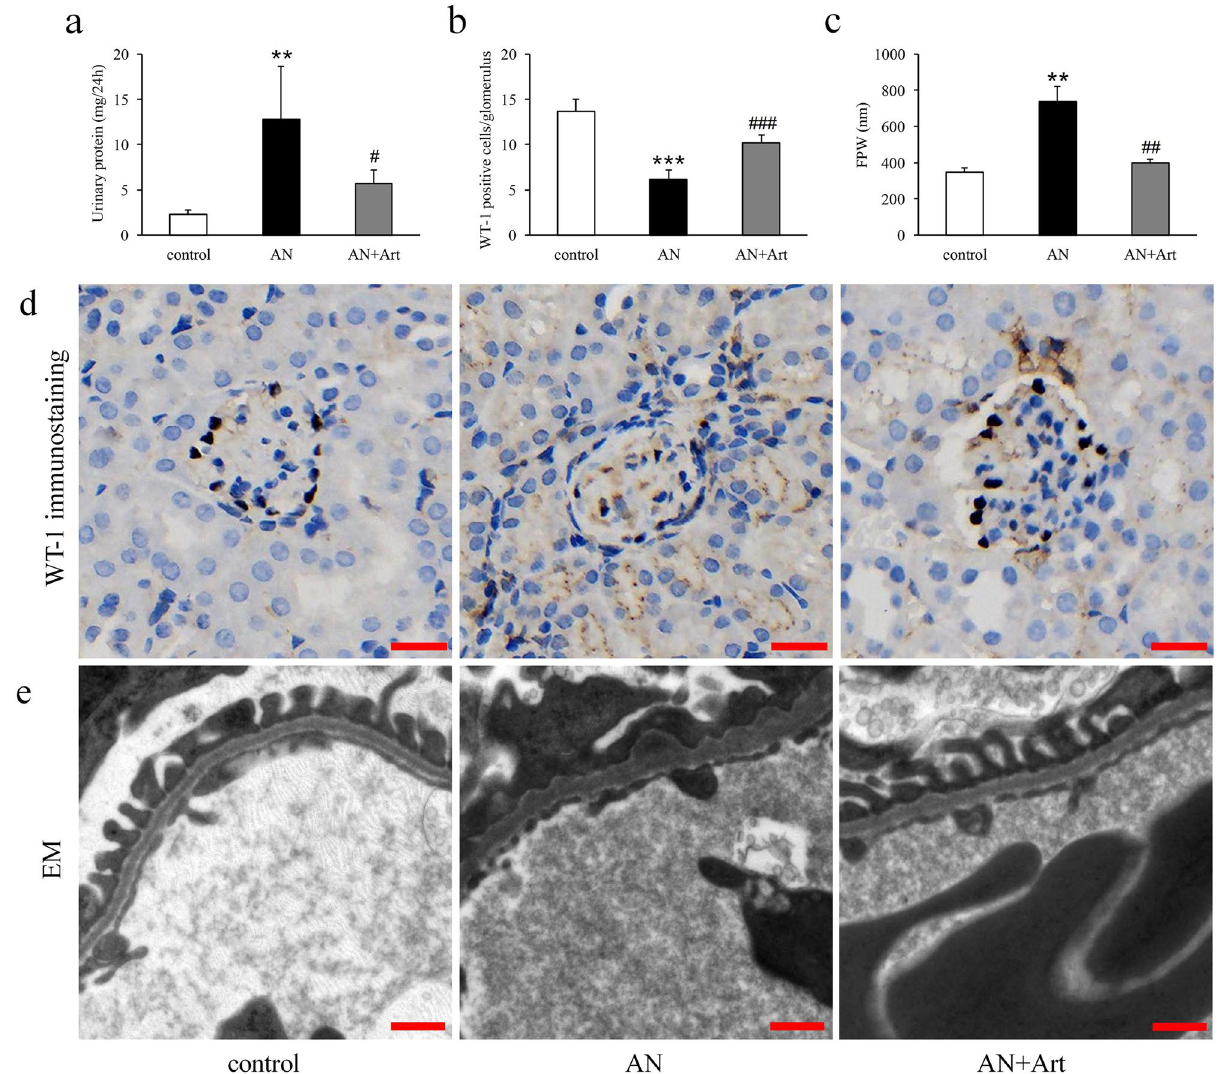
Figure 1. Artemether reduced urinary protein excretion and recovered podocyte alterations. ( a ) Quantification and statistical analysis of urinary protein excretion in various groups. n = 6 per group. ( b ) Counting of WT-1 positive cells per glomerulus in each group. n = 6 per group. ( c ) Measurement of FPW in different groups. n = 3 per group. ( d ) Representative images of WT-1 immunostaining in each group. Scale bar, 20 μm. ( e ) Representative TEM images displaying morphological changes of foot processes. Scale bar, 500 nm. ** P < 0.01 and *** P < 0.001 versus control; # P < 0.05, ## P < 0.01 and ### P < 0.001 versus